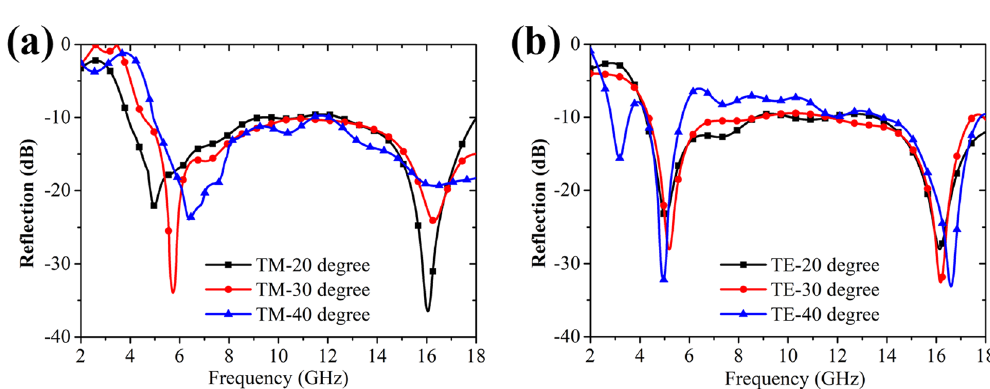
Figure 8. Measured reflectivity of the fabricated sample with the DC biasing voltages of − 1.5 V applied on the graphene layer under different oblique incident angles. ( a ) TM polarization. ( b ) TE